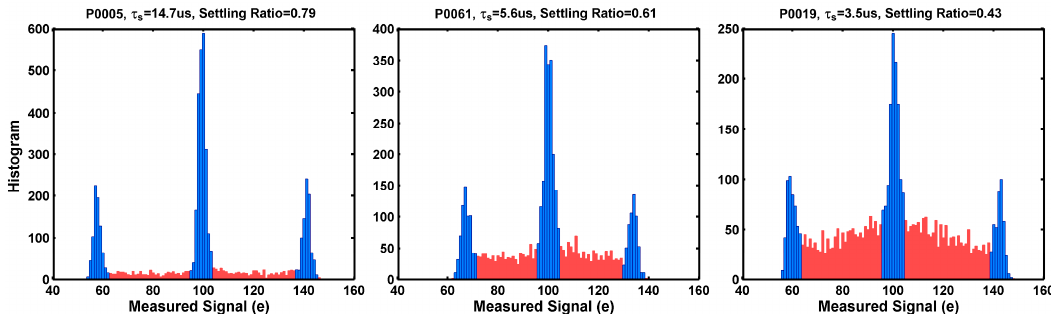
Figure 16. Due to the finite circuit settling time and the non-negligible RTN transition time, some of the data points fall into the neighborhood of the well-defined discrete levels (blue color) and some of the data points are in-between the discrete levels (red color). The settling ratio R is defined as the ratio of the settled data points versus the total data points. Three examples of pixels show the settling ratios of 0.79, 0.61, and 0.43, respectively, from left to right.